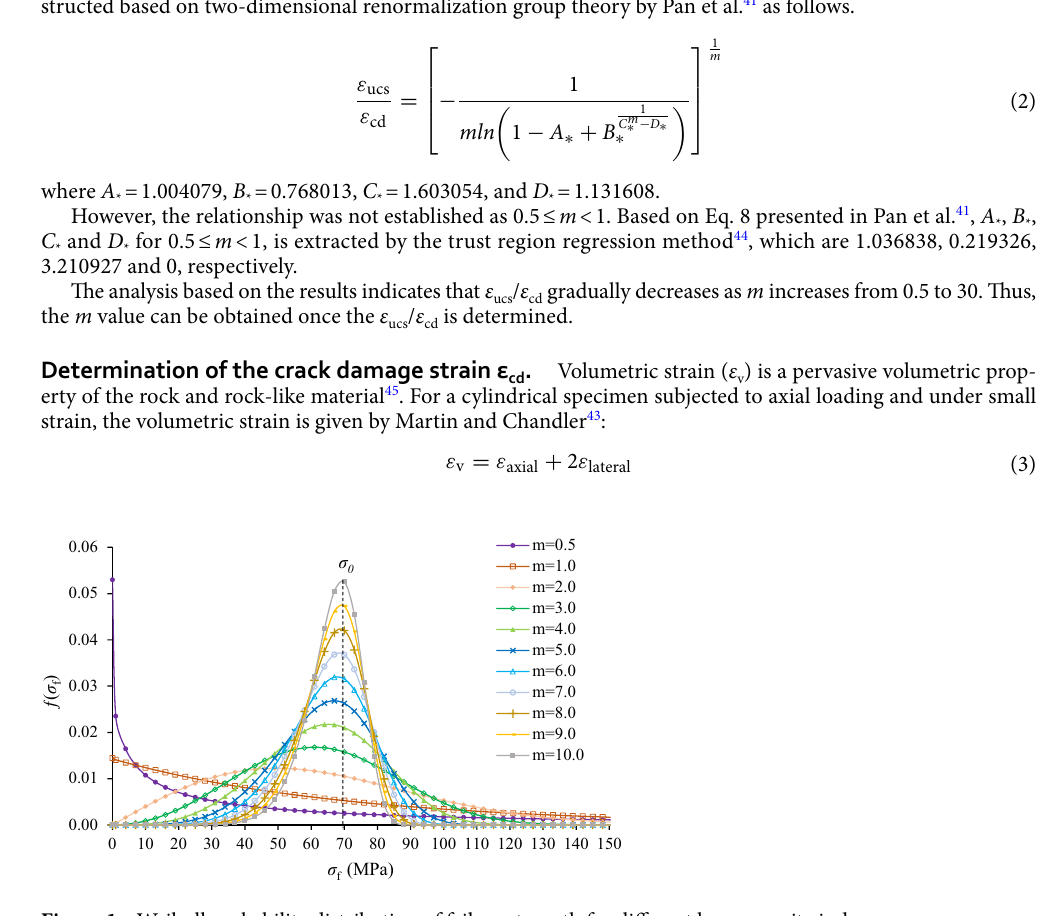
Figure 1. Weibull probability distribution of failure strength for different homogeneity index